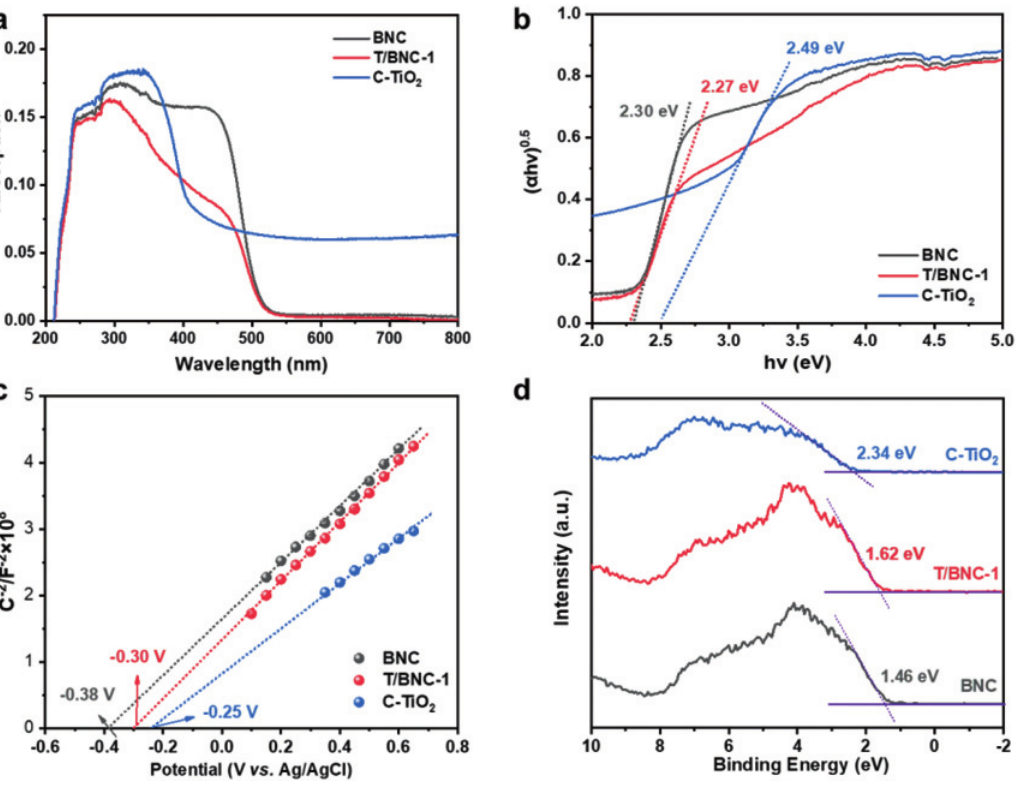
Figure4: (a)UV – visabsorptionspectra,(b)Tauc ’ splots,(c)Mott-Schottkyplotsand(d)ValencebandXPS(VB-XPS)ofpristineBNC,C-TiO 2